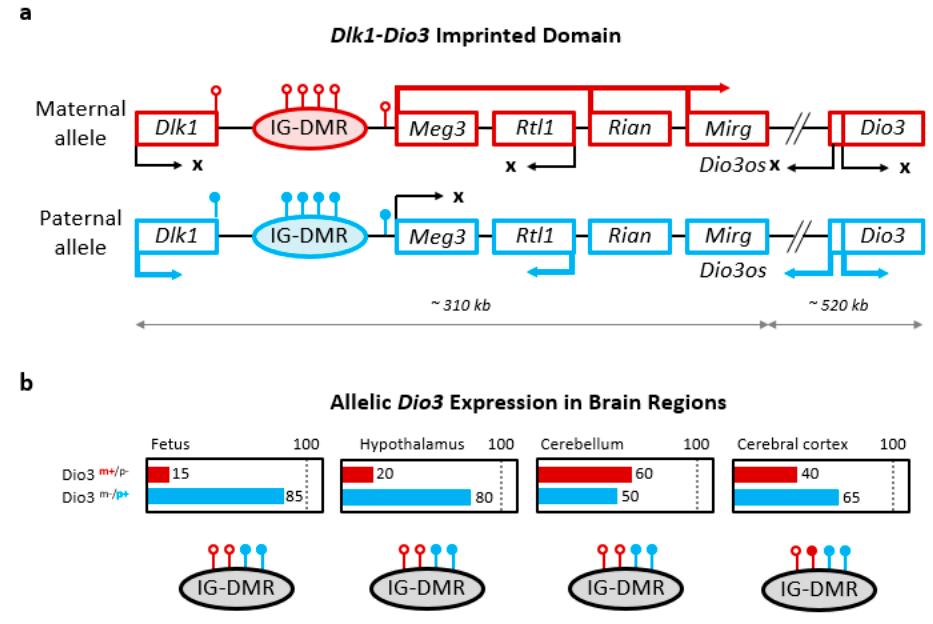
Figure 3. Genomic imprinting of Dio3 in the brain. ( a ) Simplified diagram of the mouse Dlk1-Dio3 imprinted domain showing the dominant pattern of allele-specific gene expression. An arbitrary number of pin point shapes indicate loci exhibiting allele-specific methylation (open circles, unmethylated; closed circles, methylated); ( b ) Brain variability in the percentage allelic contribution to Dio3 expression and associated IG-DMR methylation compared to fetal Dio3 . Some brain regions exhibit relaxed or absent Dio3 imprinting despite unchanged IG-DMR methylation status [37]. (Data is approximate and based on parent-of-origin inheritance of the DIO3 mutation. Allelic contributions may add more than 100%, as the wild type allele may exhibit T3-dependent up-regulation upon loss of DIO3 function in the other allele).